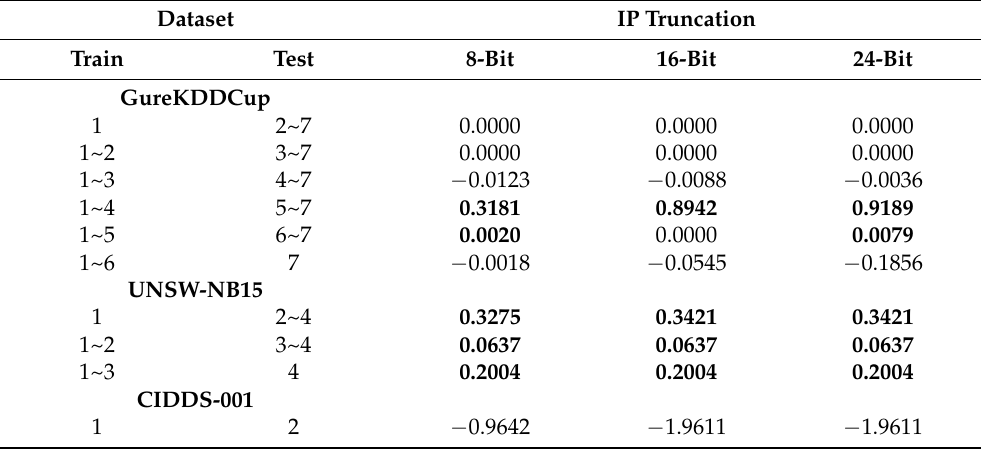
Table 5. Classification Accuracy (%) Difference for each C4.5 Model in Full GureKDDCup’99, UNSW- NB15, and